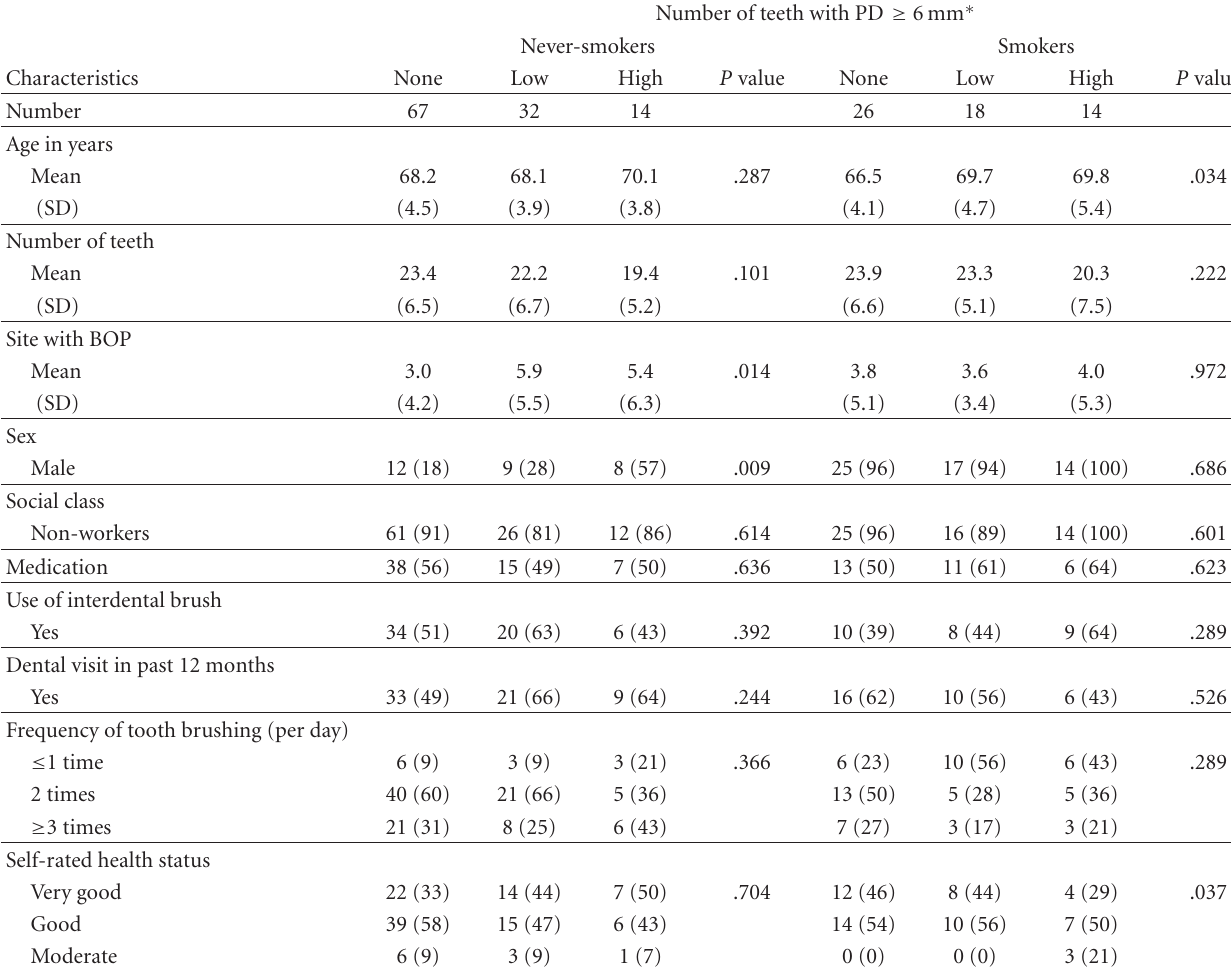
Table 2: Subject characteristics by smoking status based on CAL